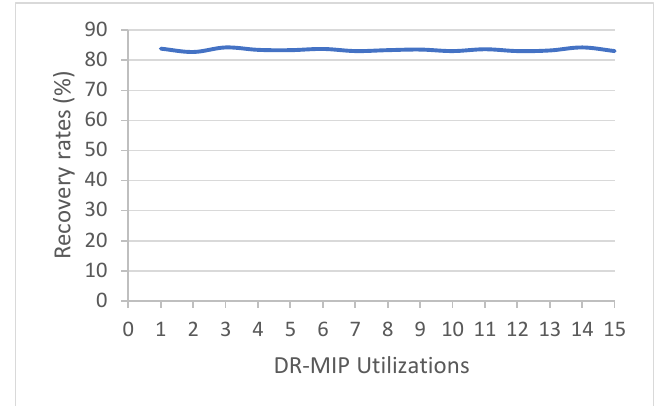
Figure 5. Reusability assays of DR-MIP.